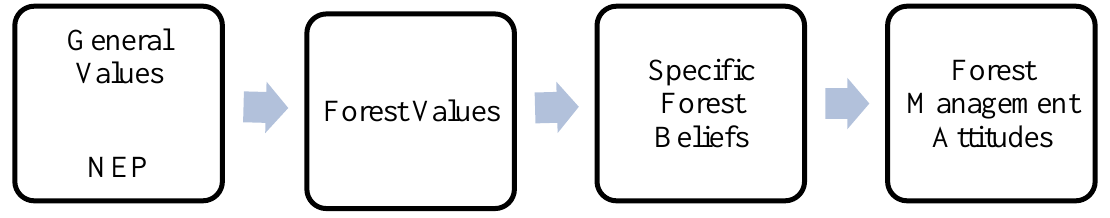
Figure 1. Conceptual representation of the proposed hierarchical model of the influence of values and beliefs on forest management